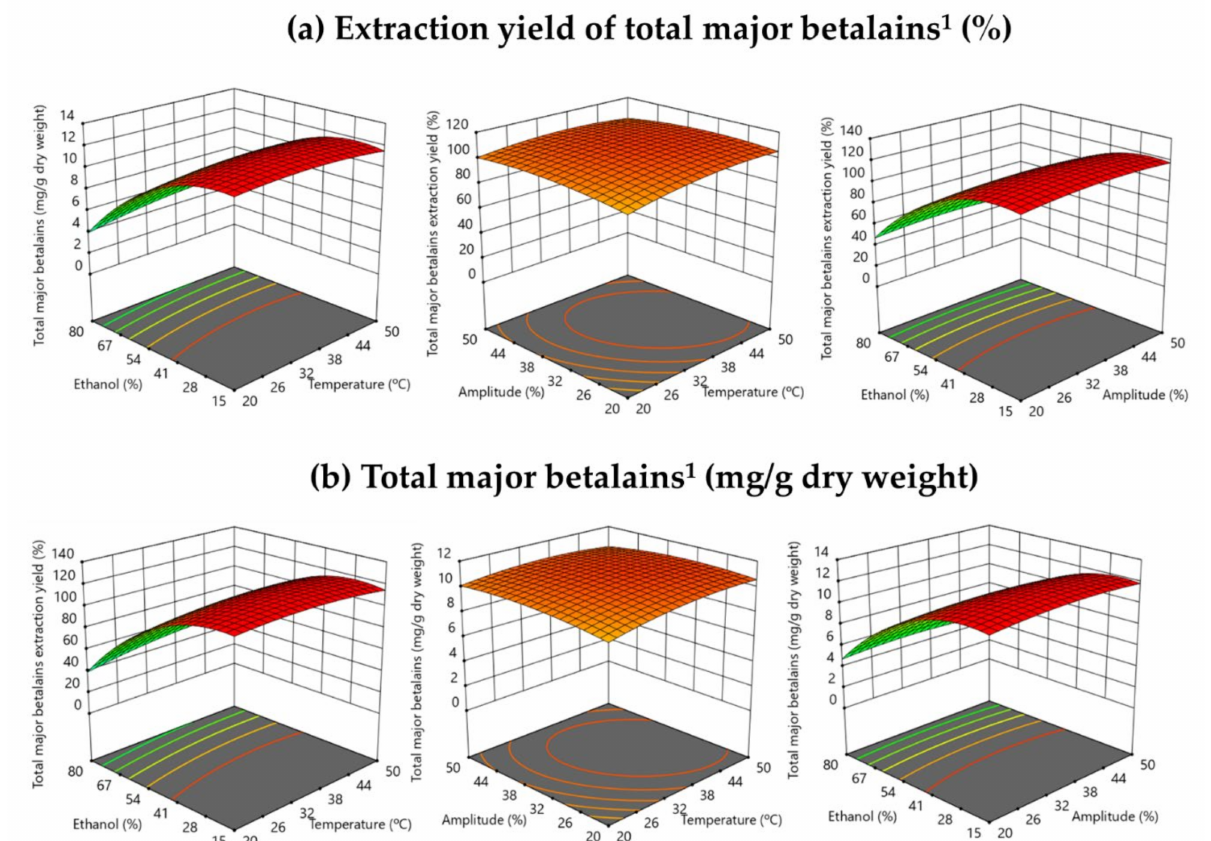
Figure 2. Response surface graph illustrating the effect of the three independent variables (amplitude (%), temperature ( ◦ C) and ethanol in solvent (%, v / v )) on total major betalains ( a ) extraction yield (%) and content (mg/g dry weight). 1 The sum of most abundant betalains: betanin, isobetanin, 2 (cid:48) -O-apiosyl-4-O-phyllocactin, 5 (cid:48)(cid:48) -O-E-sinapoyl-2 (cid:48) -apyosil-phyllocactin and